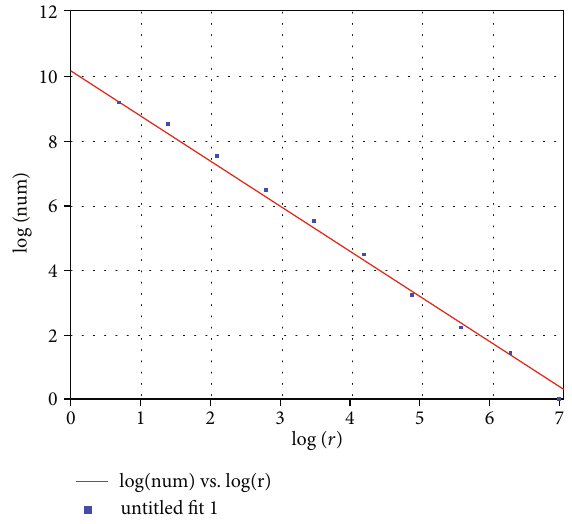
Figure 17: The damage fractal characteristics fi tted to the shale at a stress level of 100% and quartz content of